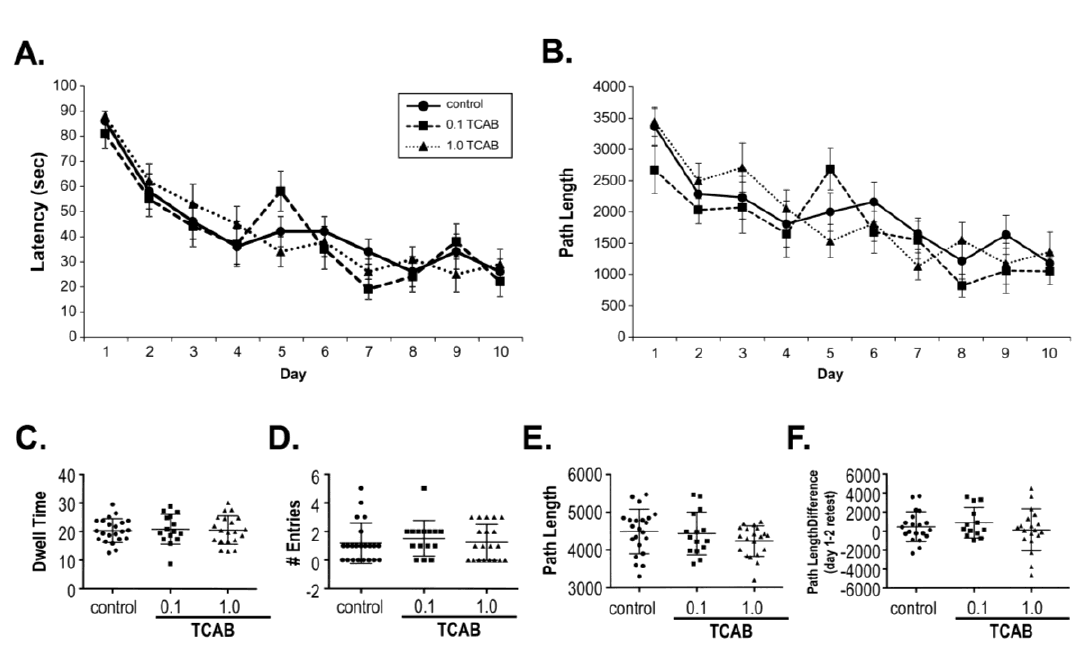
Figure 5. Morris Water Maze. Acquisition of a Morris water maze task over 10 consecutive days of training in PND91-95. ( A ) Latency (s); ( B ) path length to reach the hidden escape platform. In the probe trial; ( C ) dwell time (s) within the platform quadrant; ( D ) number of entries into the platform quadrant and ( E ) path length were recorded; ( F – G ) Reversal learning ( F ) latency and ( G ) path length. Data represents mean ± SEM, n =